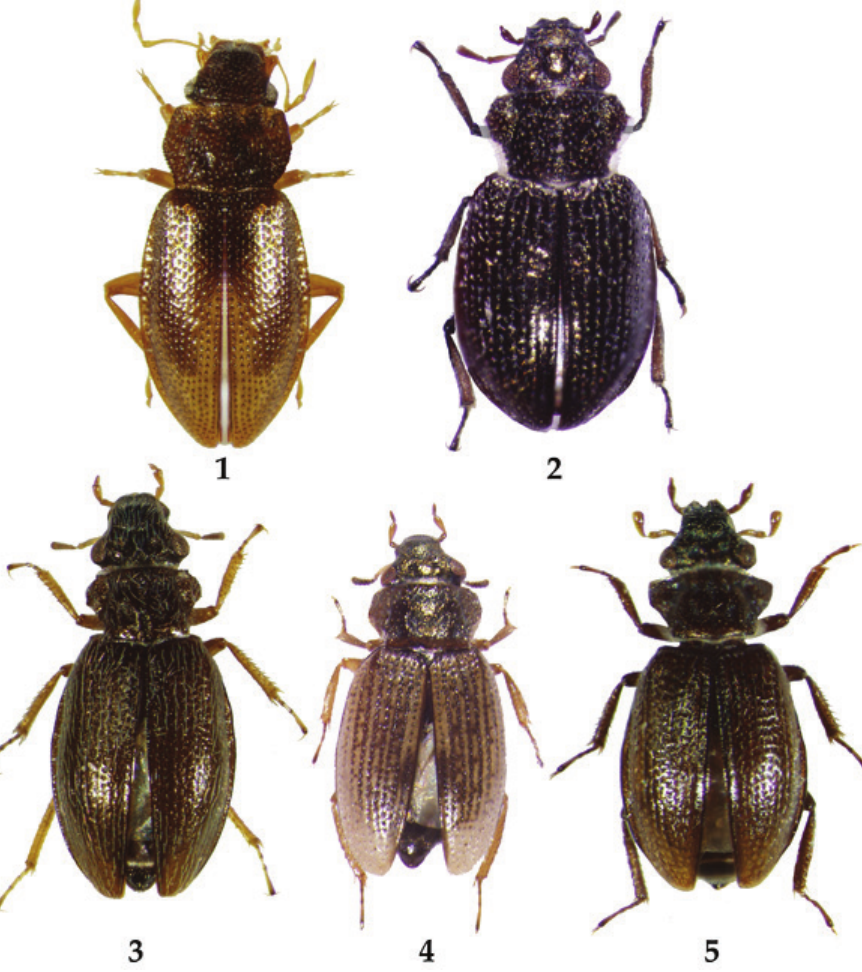
Figures 1–5. Habitus. 1 Hydraena puetzi , 2.2 mm 2 Ochthebius hasegawai , 1.8 mm 3 O. lobatus , 2.2 mm 4 O. marinus , 2.0 mm 5 O. satoi , 1.8